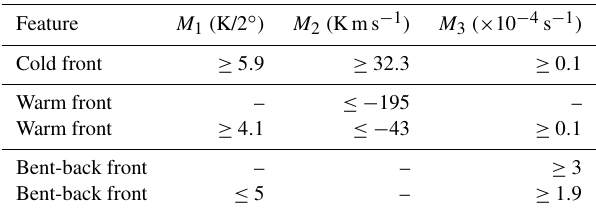
Table 2. Thresholds used to identify the cold, warm, and bent-back